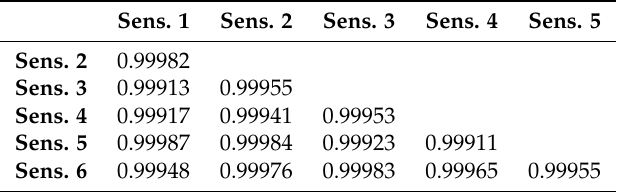
Figure 10. DHT22 Refrigerator test, Relative Humidity (%). Table 6. Correlation between different instances of DHT22 - Temperature sensor.